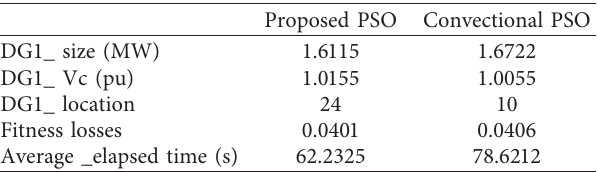
Table 2: Comparison between adapted PSO algorithms and the proposed algorithm.